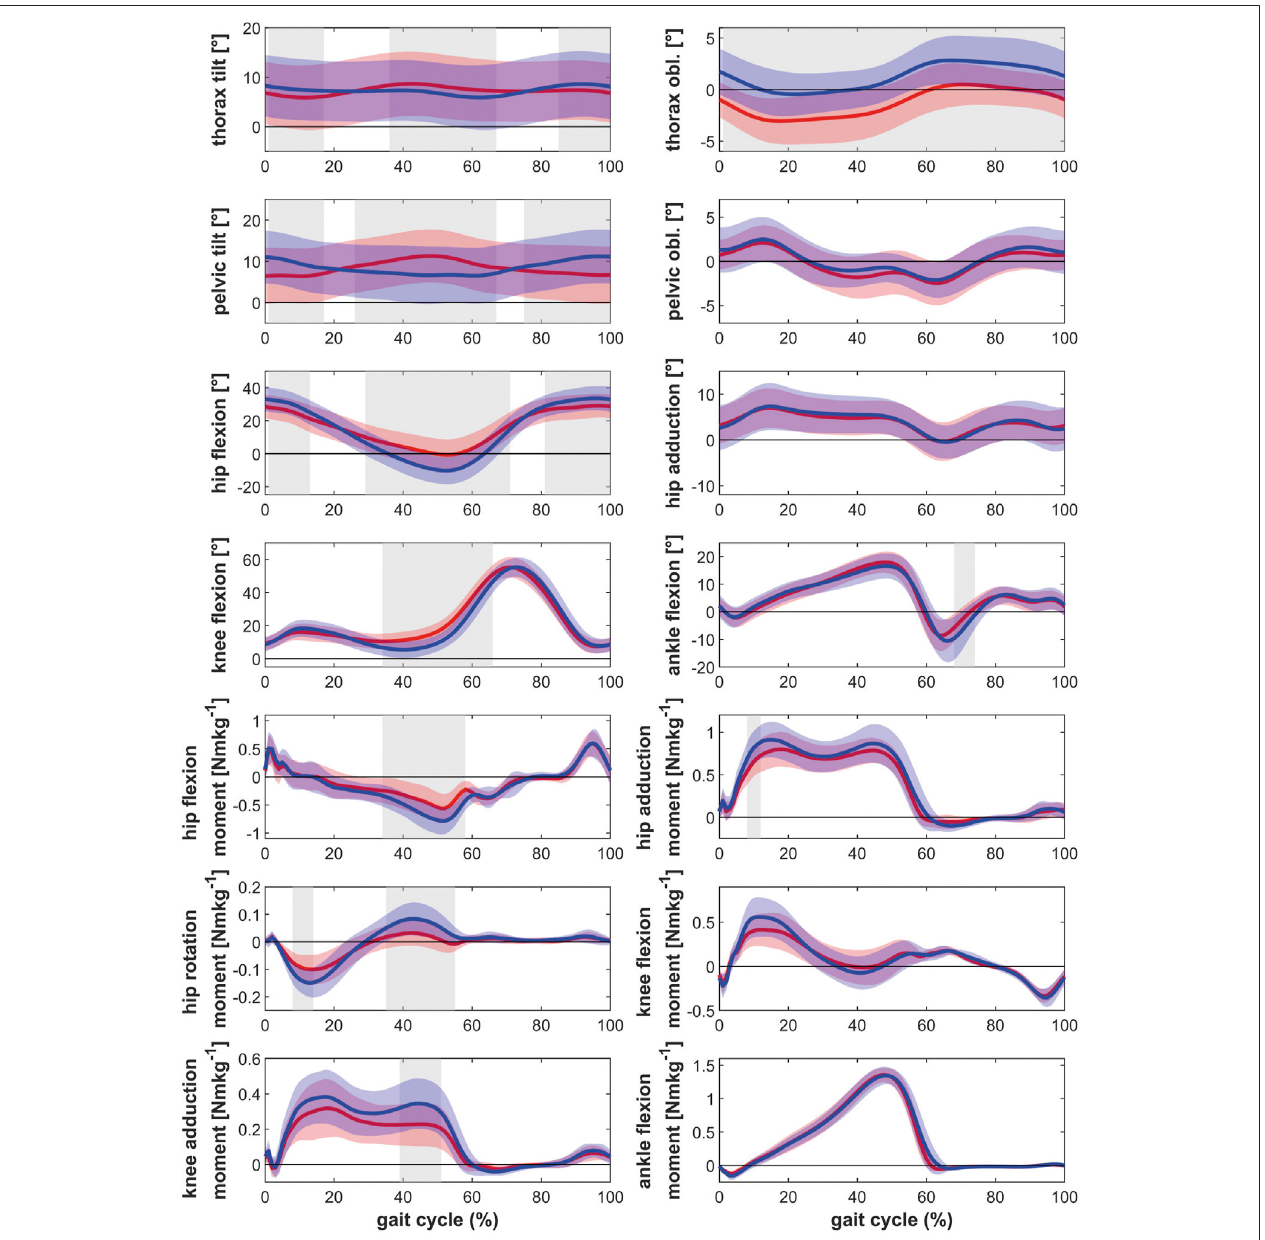
FIGURE 6 | Comparison of the kinematics and kinetics between the ipsilateral and contralateral leg of unilateral hip OA patients. Mean and one standard deviation of the joint angles and the external joint moments. Shaded areas indicate statistical differences. Red lines (cid:1) ipsilateral leg, blue lines (cid:1) contralateral leg. (A) thorax tilt: anterior (+)/posterior ( − ); (B) thorax obliquity: towards the contralateral side (+)/towards the ipsilateral side ( − ); (C) pelvic tilt: anterior (+)/posterior ( − ); (D) pelvic obliquity: up (+)/down ( − ); (E) hip fl exion/extension: fl exion (+)/extension ( − ); (F) hip adduction/abduction: adduction (+)/abduction ( − ); (G) knee fl exion/extension: fl exion (+)/extension ( − ); (H) ankle dorsi fl exion/plantar fl exion: dorsi fl exion (+)/plantar fl exion ( − ); (I) hip fl exion/extension moment: fl exion (+)/extension ( − ); (J) hip adduction/ abduction moment: adduction (+)/abduction ( − ); (K) hip rotation moment: internal rotation (+)/external rotation ( − ); (L) knee fl exion/extension moment: fl exion (+)/extension ( − ); (M) knee adduction/abduction moment: varus (+)/valgus ( − ); (N) ankle dorsi fl exion/plantar fl exion moment: dorsi fl exion (+)/plantar fl exion ( −